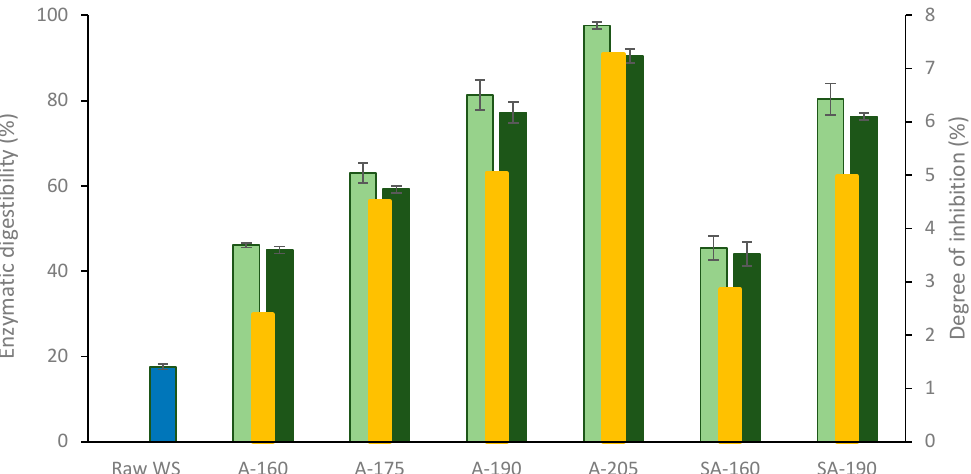
Figure 3. Enzymatic digestibility of glucan in cut raw wheat straw (WS) in buffer (blue bar) and pretreated solids suspended in either sodium citrate buffer (light green bars) or pretreatment liquid (dark green bars). Yellow bars represent the degree of inhibition (DI) of enzymatic saccharification by the pretreatment liquids. Same codification of experimental conditions as in Table 1.